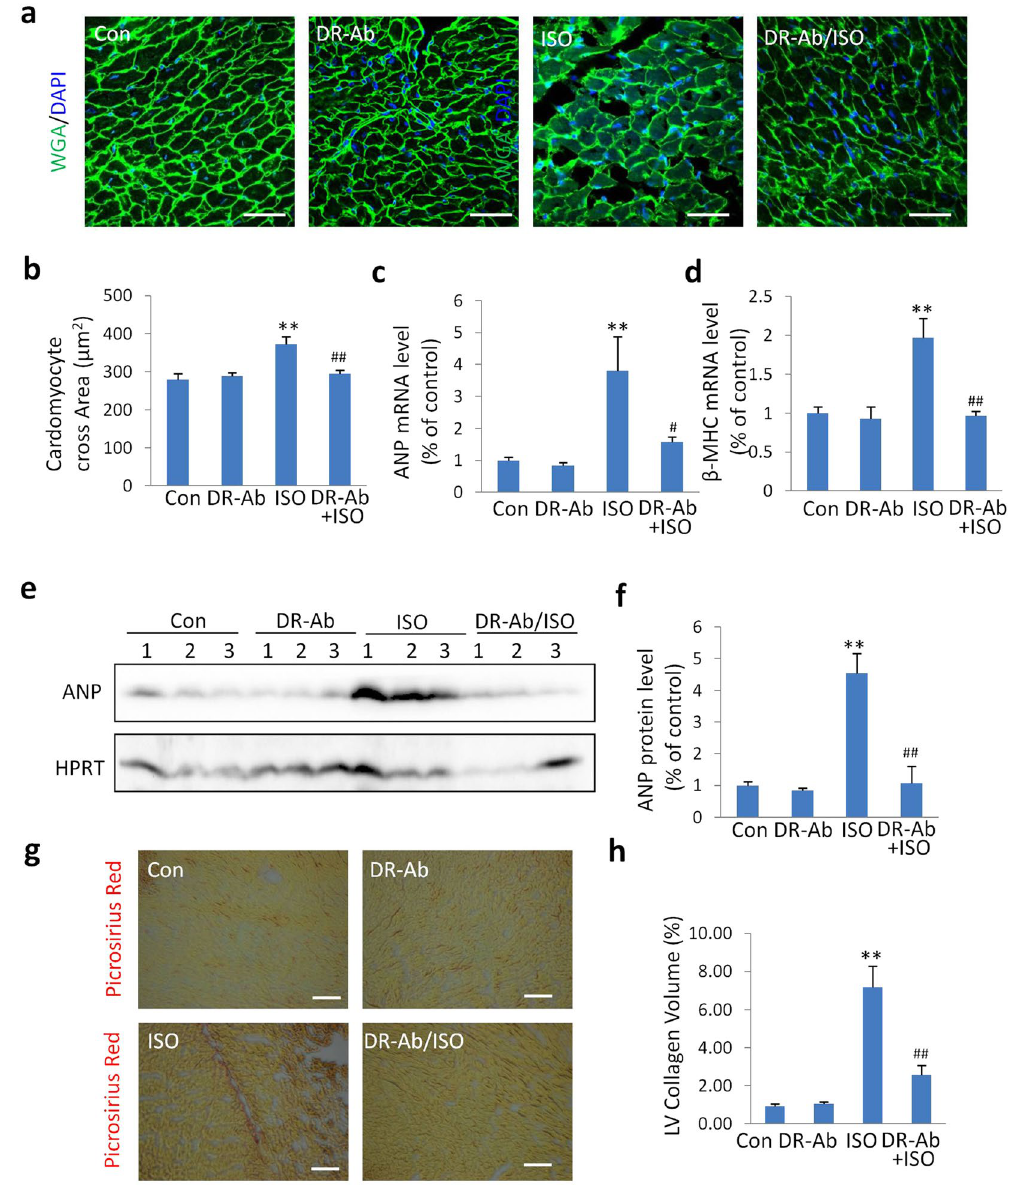
Figure 2. Protective effects of DR-Ab against ISO-induced hypertrophy. ( a ) Representative images of FITC- conjugated wheat germ agglutinin (WGA) staining of hearts from each group; scale bar, 50 μ m; ( b ) Quantitative results of the cardiomyocyte cross sectional area in each group (n = 150 cells per group); ( c,d ) The relative mRNA levels of hypertrophic marker ANP ( c ) and β -MHC ( d ) over GAPDH (n = 4–5); ( e,f ) Representative Western blots ( e ) and quantification ( f ) of ANP to HPRT in each group (n = 5–8). ( g ) Representative images of picrosirius red staining of hearts from each group; scale bar, 50 μ m; ( h ) Quantitative results of the left ventricular (LV) collagen volume in each group (n = 10 fields per group); Mean ± SEM. * p < 0.05, ** p < 0.01, *** p < 0.001 vs control; # p < 0.05, ## p < 0.01, ### p < 0.001 vs